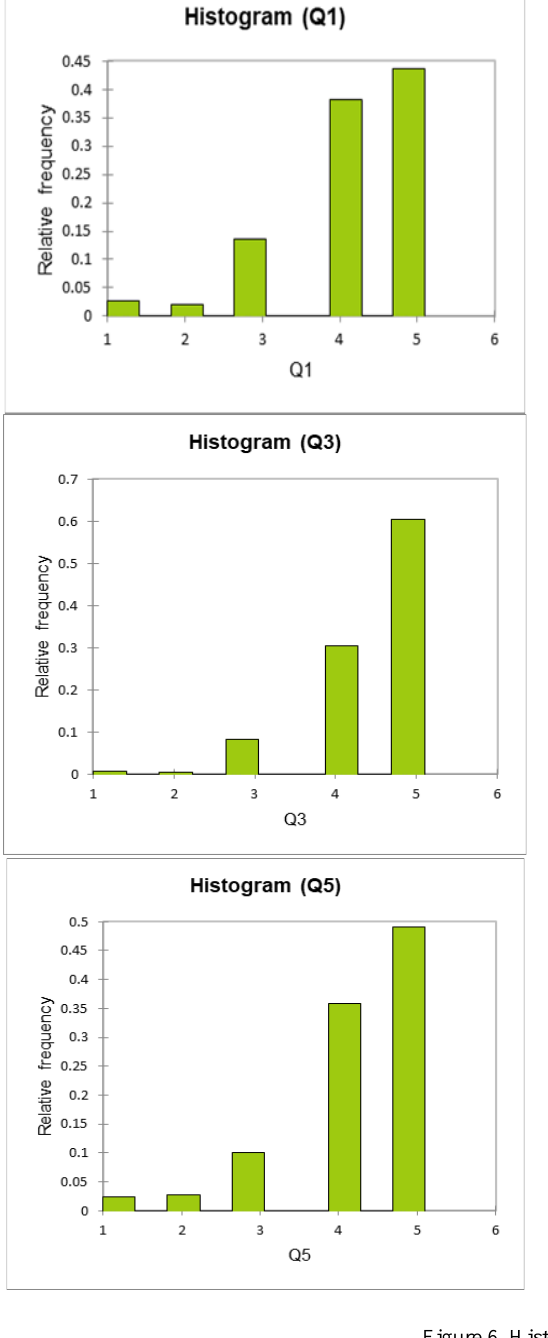
Figure 6. Histograms of